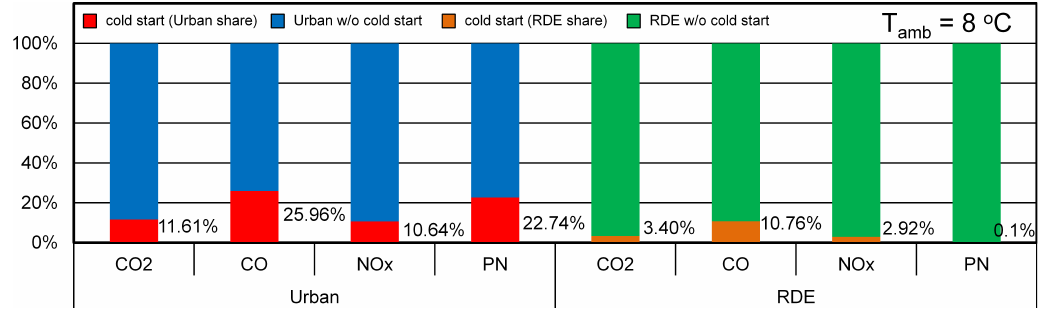
Figure 10: The share of exhaust emissions during the cold start in relation to the urban part of the RDE test, and the entire RDE test for an ambient temperature of 8 ∘ C